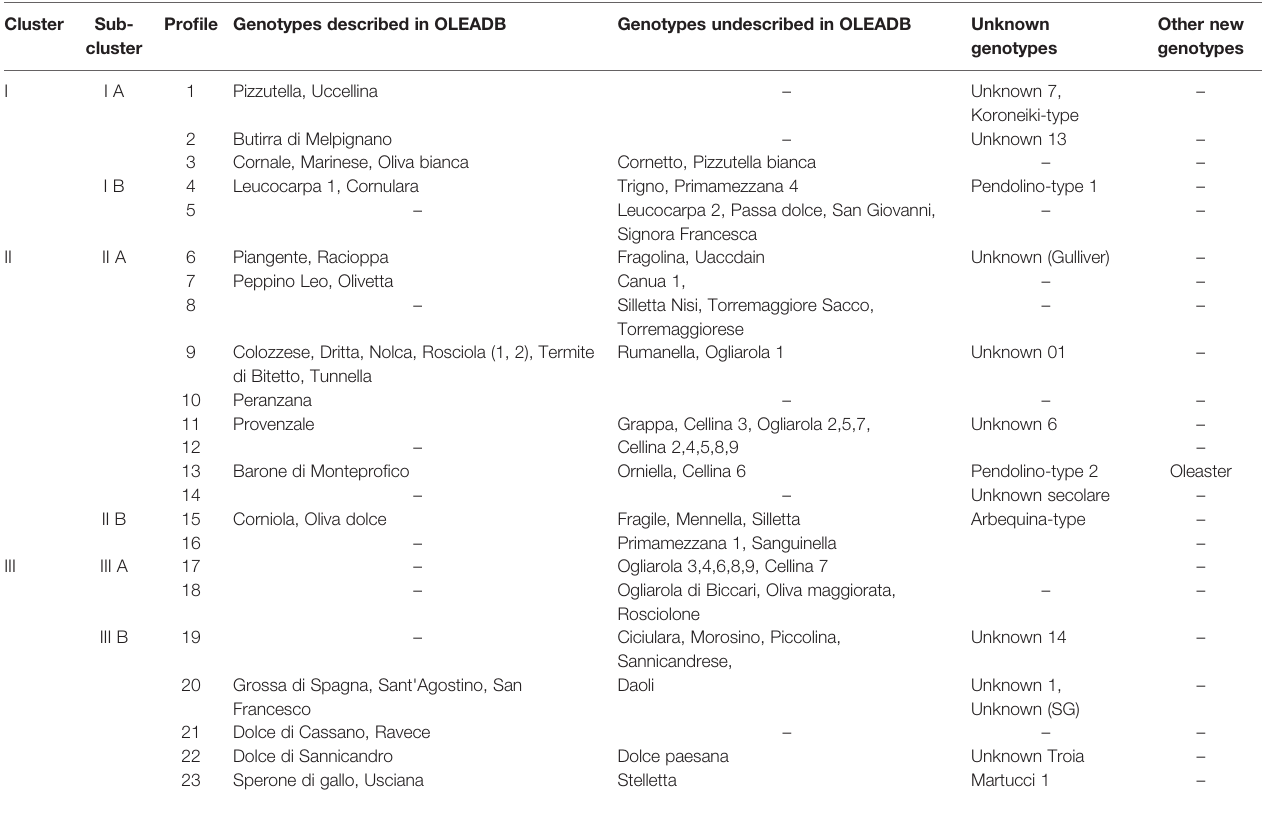
TABLE 1 | Results of the clustering of the 97 Apulian genotypes based on morphological traits. Known genotypes indicate genotypes present in the databank OLEADB. Cluster Sub- Pro fi le Genotypes described in cluster